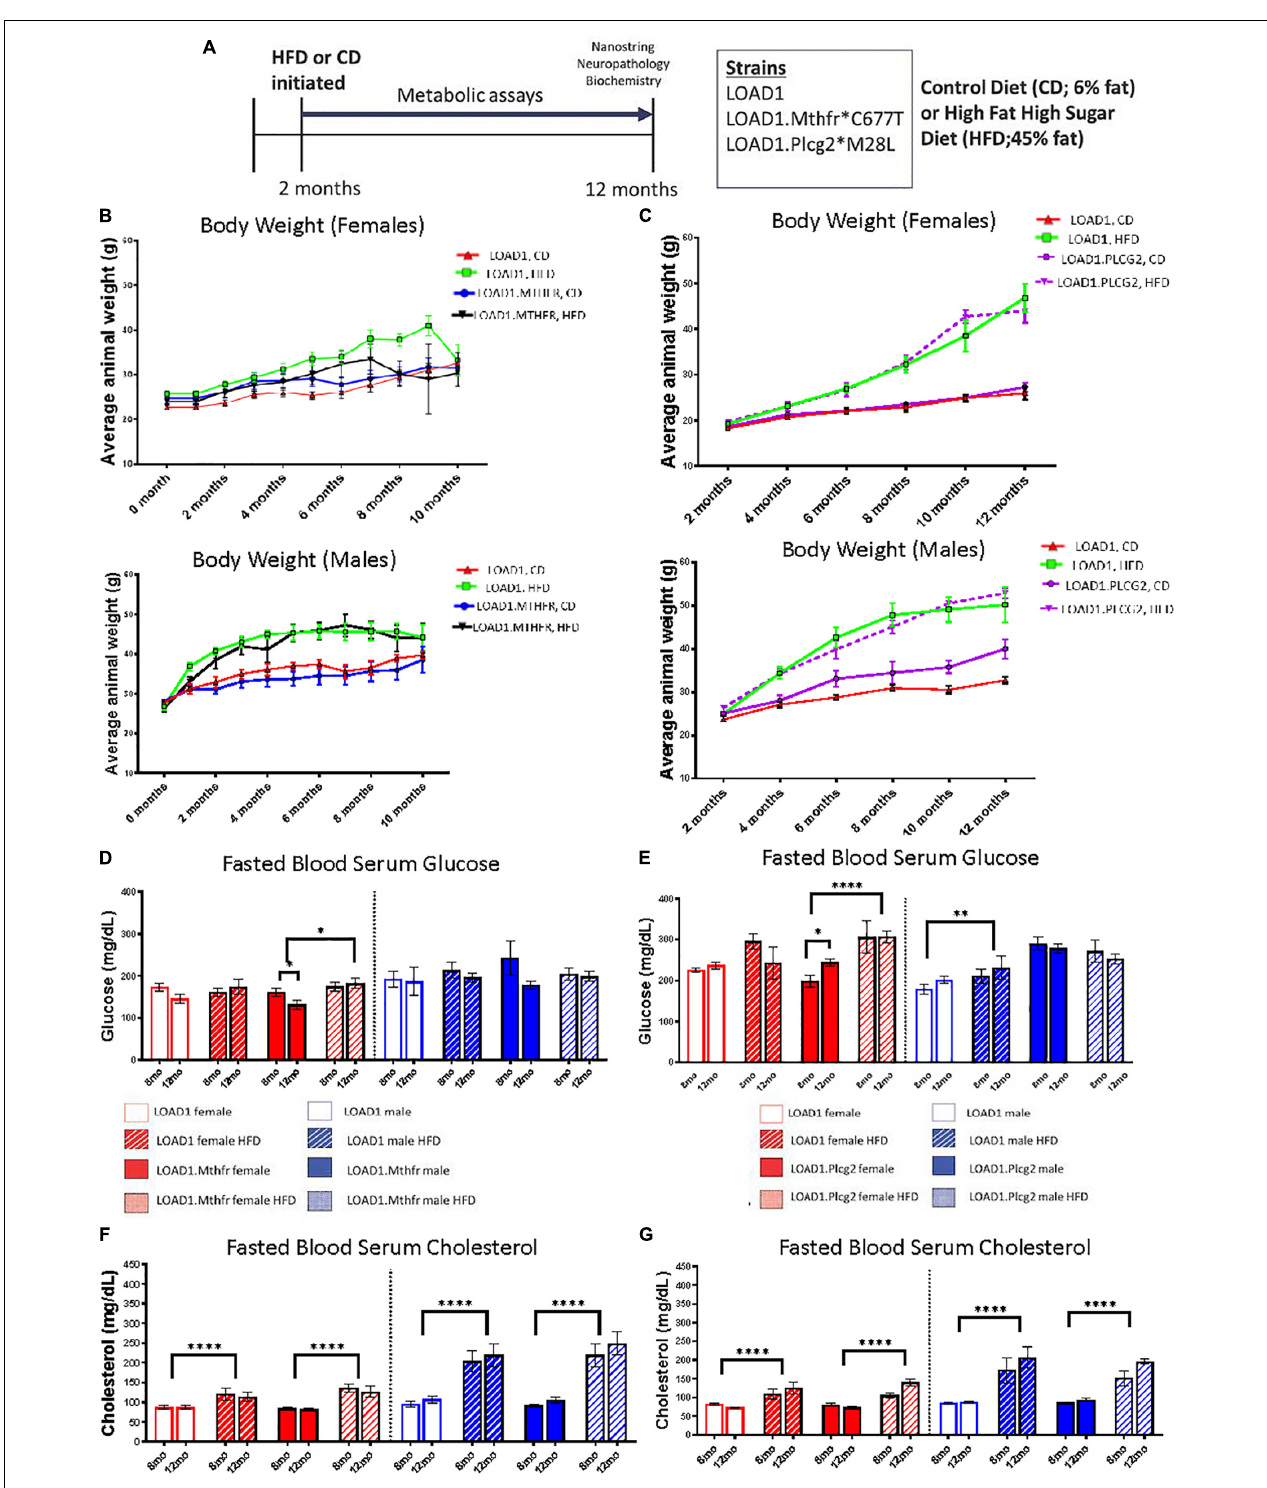
FIGURE 1 | Bodyweight, glucose, and cholesterol increased on a high fat/high sugar (HFD) diet, regardless of genotype. LOAD1, LOAD1. Mthfr 677 C > T , and LOAD1. Plcg2 M 28 L mice were fed with a control diet (CD) or HFD from 2 to 12 months of age (A) . At multiple timepoints throughout the study, blood was collected. At the terminal time point, transcriptomics, limited neuropathology, and biochemical studies were completed. Over the course of the study, regardless of genotype or sex, mice fed with HFD gained more weight than animals fed with a control diet (B) . Glucose (D,E) and Cholesterol (F,G) increased over time, which was related to diet, but not to genotype (C–F) . A mixed ANOVA with repeated measures was completed; p < 0.05 is considered significant. * p < 0.05, ** p < 0.01, **** p < 0.0001.